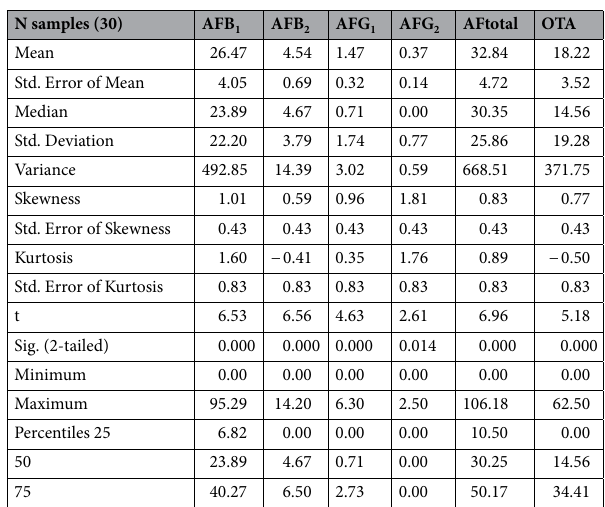
Table 3. Statistical summary of data obtained from the Upper East Region of Ghana.